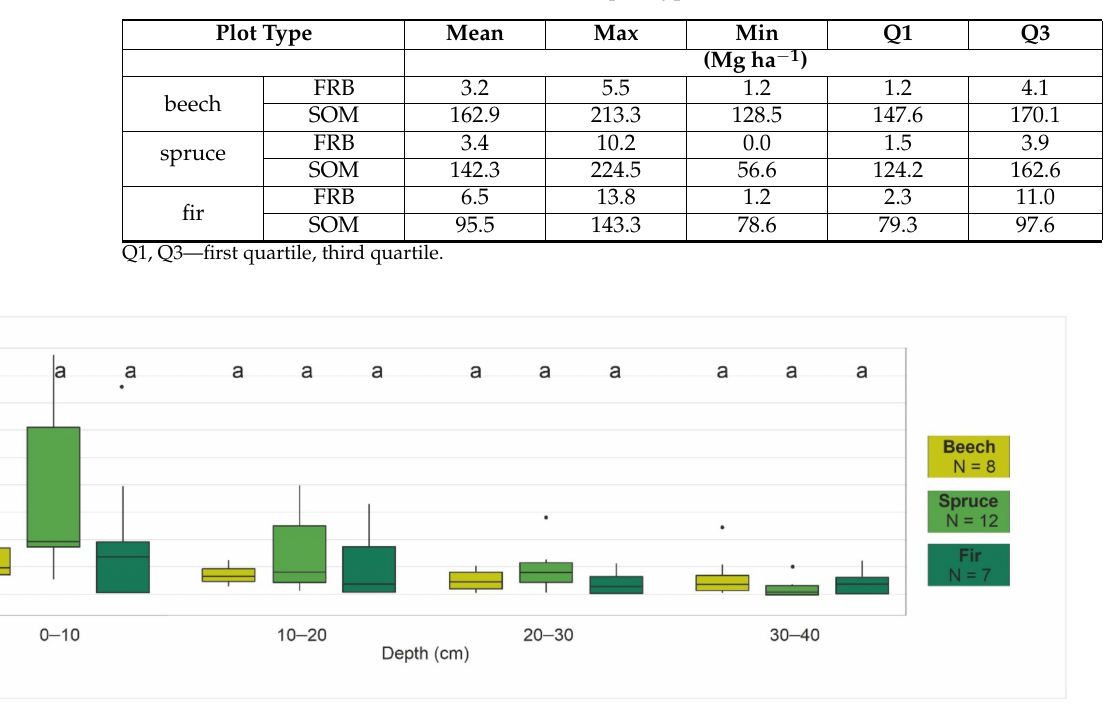
Table 7. FRB and SOM stocks (0 to 40cm) at each plot type.